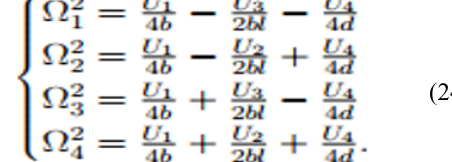
Fig. 9. Operating algorithm of the robot After starting the program, the peripherals of the microcontroller are initialized, and then the program in the infinite loop: receives the signals from the sensors, determines the control of the engine regulators and communicates with the auxiliary microcontroller. Each robot function has been assigned the frequency with which it should be performed.